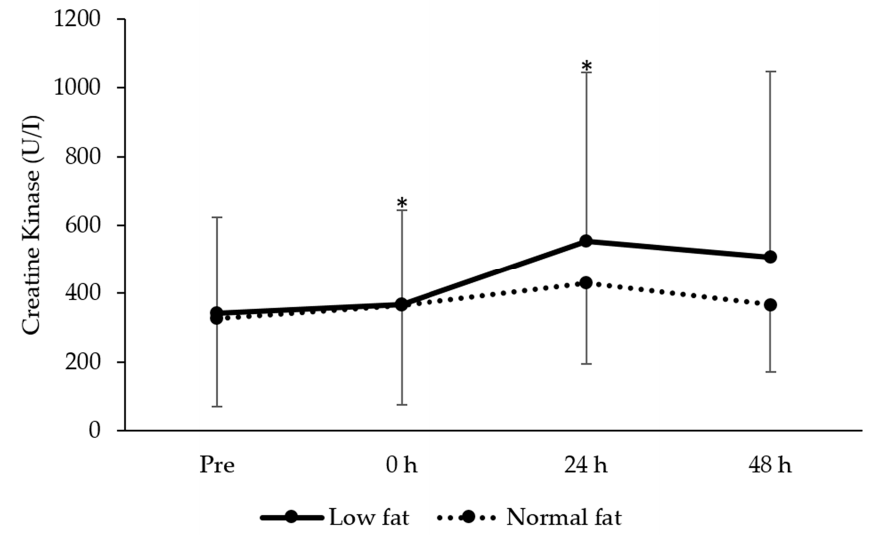
Figure 2. Changes in creatine kinase (mean ± standard deviation) between low- and normal-fat groups at pre, 0, 24 and 48 h after resistance exercise. * denotes significantly different from pre for the whole sample ( P < 0.05).